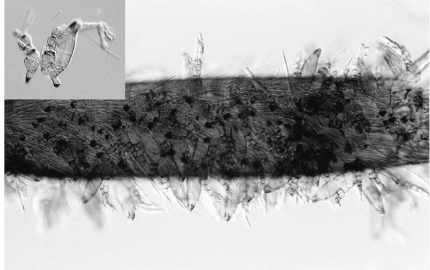
Figure 6: Laboulbenia formicarum on Lasius grandis . Worker tibia, showing full-grown thalli and dark spots which indicate attachment point of spores (more than 50 in the viewed side). Inset: one mature (right) and immature (left) specimens of Laboulbenia formicarum .